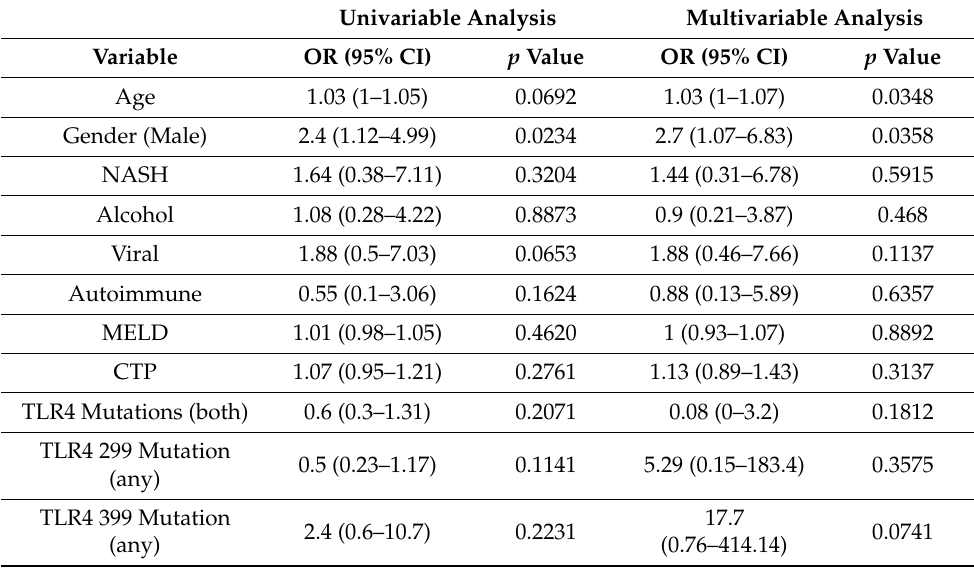
Table 2. Uni- and multivariable analyses for HCC development. p values in bold indicate statistical